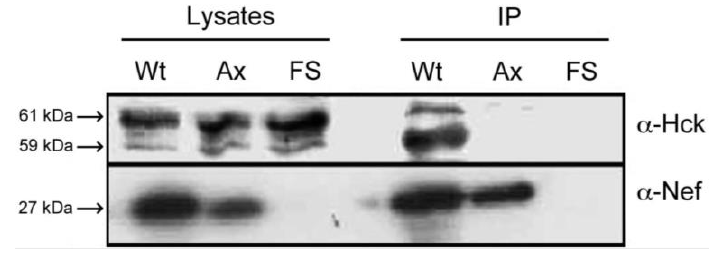
Figure 1. Co-precipitation of Hck from HIV-1 infected macrophages by Nef. Lysates of primary Monocyte-Derived Macrophages (MDM) infected with AD8 (Wt), AD8AxxA (Ax) or AD8FSNef (FS) were immunoprecipitated with sheep anti-Nef sera. Immunoblots of cellular lysates and precipitates were probed with anti-Nef and anti-Hck monoclonal antisera. Data are representative of 3 independent